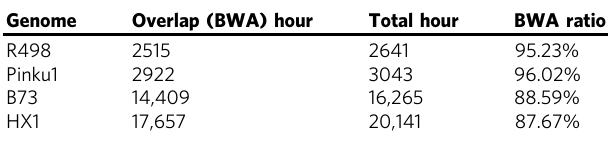
Table 2 The running time of